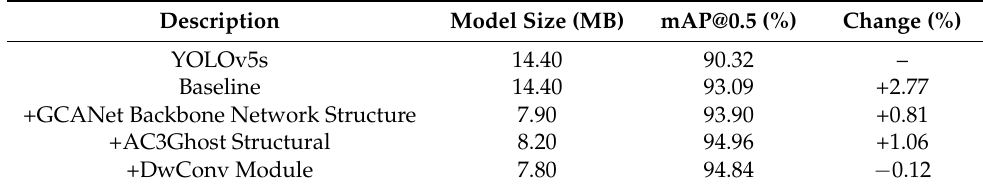
Table 3. Effects of various design modules on surface